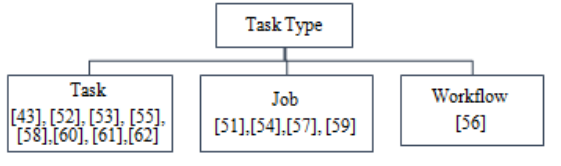
Fig. 4. Task scheduling